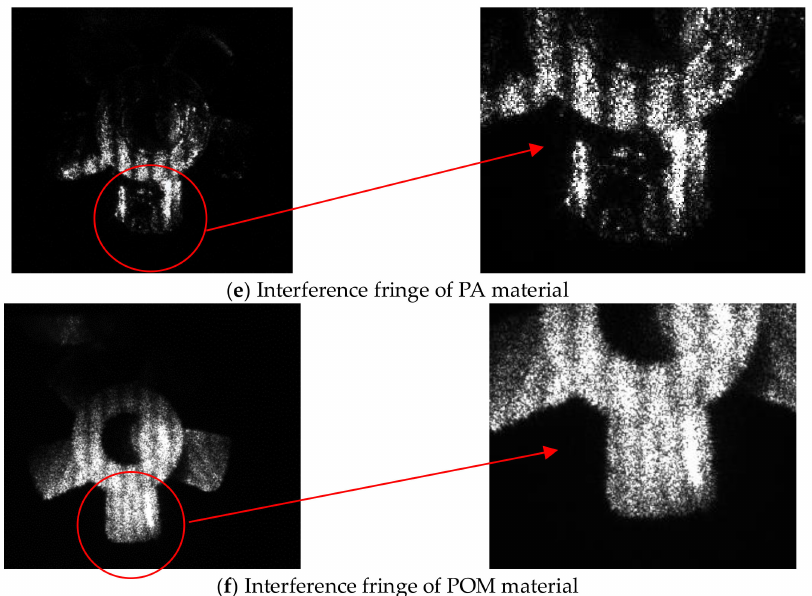
Figure 8. The interference fringes and situations for measurement method for micro-sized part with various plastics. ( a ) Measurement diagram; ( b ) Interference fringe of PP material; ( c ) Interference fringe of ABS material; ( d ) Interference fringe of ABS + PC material; ( e ) Interference fringe of PA material; ( f ) Interference fringe of POM material.